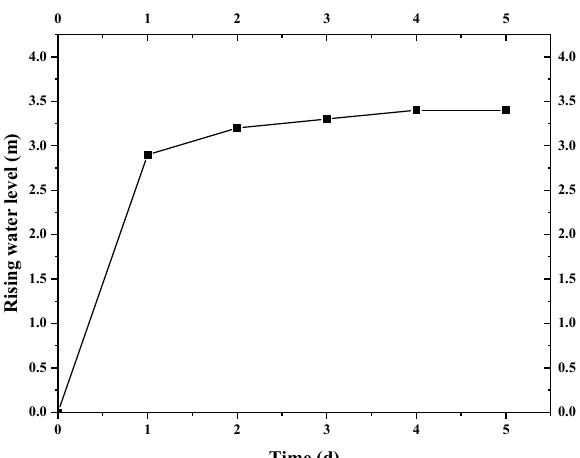
Figure 11. Relation curve between rising water level and time in pit after reinjection.